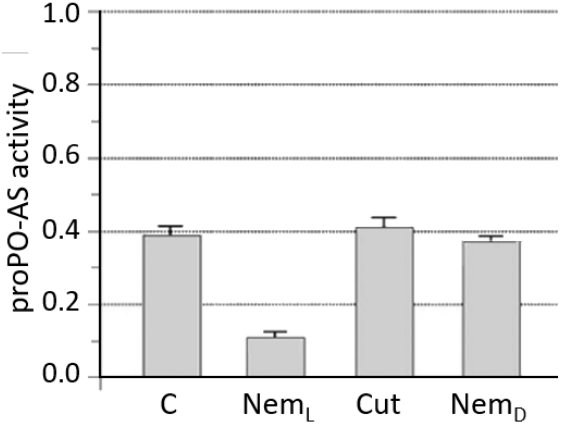
Figure 17. Effects of S. carpocapsae on proPO-AS activity. The presence of live nematodes induces a marked inhibition of the host phenoloxidase activity (Nem L ); instead, either dead parasites (Nem D ) or isolated cuticles (Cut) do not affect the host proPO-AS. C: basal PO activity recorded as control, (from [162]).